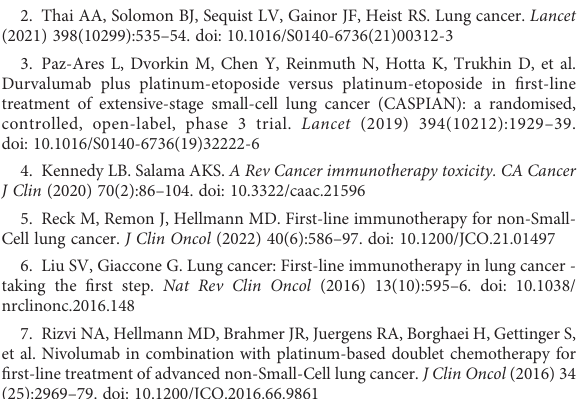
(B) Heatmap of module-trait relationships associated with macrophage in fi ltration. (C) Module genes relevant heatmap related to macrophage in fi ltration. (D) Scatter plot of correlation between modules and gene features. SUPPLEMENTARY FIGURE 2 Sample clustering, molecular typing, and prognosis evaluation analyses based on TAMs-related-genes. (A) Subtypes of clustering pro fi les obtained through analysis of the expression pro fi les of TAMs-related- genes in TCGA-LUAD samples (consensus matrix k=3). (B) Subtypes of consistent clustering pro fi les obtained through analysis of the expression pro fi les of TAMs-related-genes in GSE13213 samples (consensus matrix k=3). (C) Subtypes of the consistent clustering pro fi les obtained from GSE31210 samples (consensus matrix k=2). (D) Clustering pro fi les from GSE72094 samples (consensus matrix k=2). (E) GSE8894 samples (consensus matrix k=3). (F) Survival analysis of different cluster subtypes in TCGA-LUAD samples. (G) Results of survival analysis of different cluster subtypes in GSE13213 samples; The horizontal axis represents survival time; the vertical axis represents survival probability; Curves with different colors represent different cluster subtypes. (H) Results of survival analysis of different cluster subtypes in GSE31210 samples; The horizontal axis represents survival time; the vertical axis represents survival probability; Curves with different colors represent different cluster subtypes. (I) Results of survival analysis of different cluster subtypes in GSE72094 samples; The horizontal axis represents survival time; the vertical axis represents survival probability; Curves with different colors represent different cluster subtypes. (J) Results of survival analysis of different cluster subtypes in GSE8894 samples; The horizontal axis represents survival time; the vertical axis represents survival probability; Curves with different colors represent different cluster subtypes. (K) Results of principal component analysis (PCA) on TCGA-LUAD samples; (L) Results of principal component analysis (PCA) on GSE13213 samples; (M) Results of principal component analysis (PCA) on GSE31210 samples; (N) Results of principal component analysis (PCA) on GSE72094 samples; (O) Results of principal component analysis (PCA) on GSE8894 samples. SUPPLEMENTARY FIGURE 3 Single-cell data. (A) Number of genes expressed in cells; (B) Total counts. (C) Mitochondrial gene expression. (D – I) UMAP (Uniform Manifold Approximation and Projection) dimensionality reduction analysis results